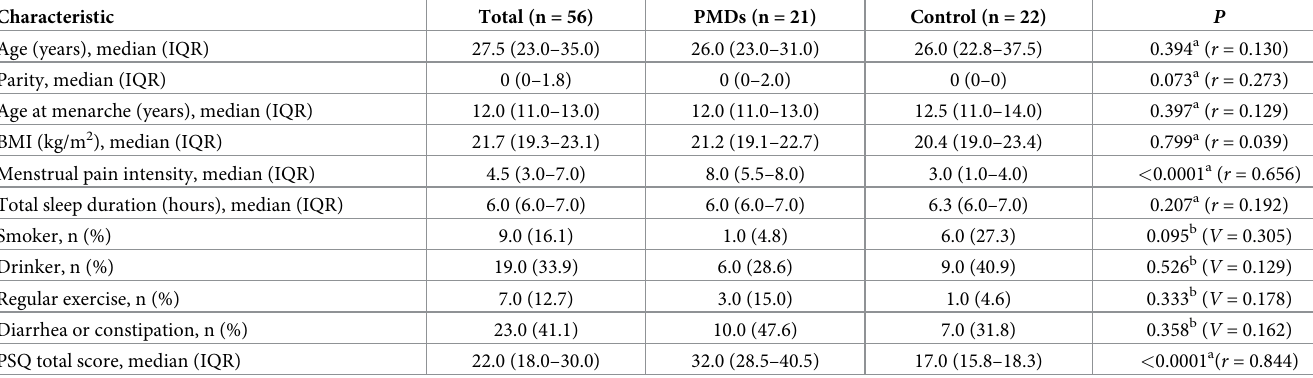
Table 1. Characteristics of the study